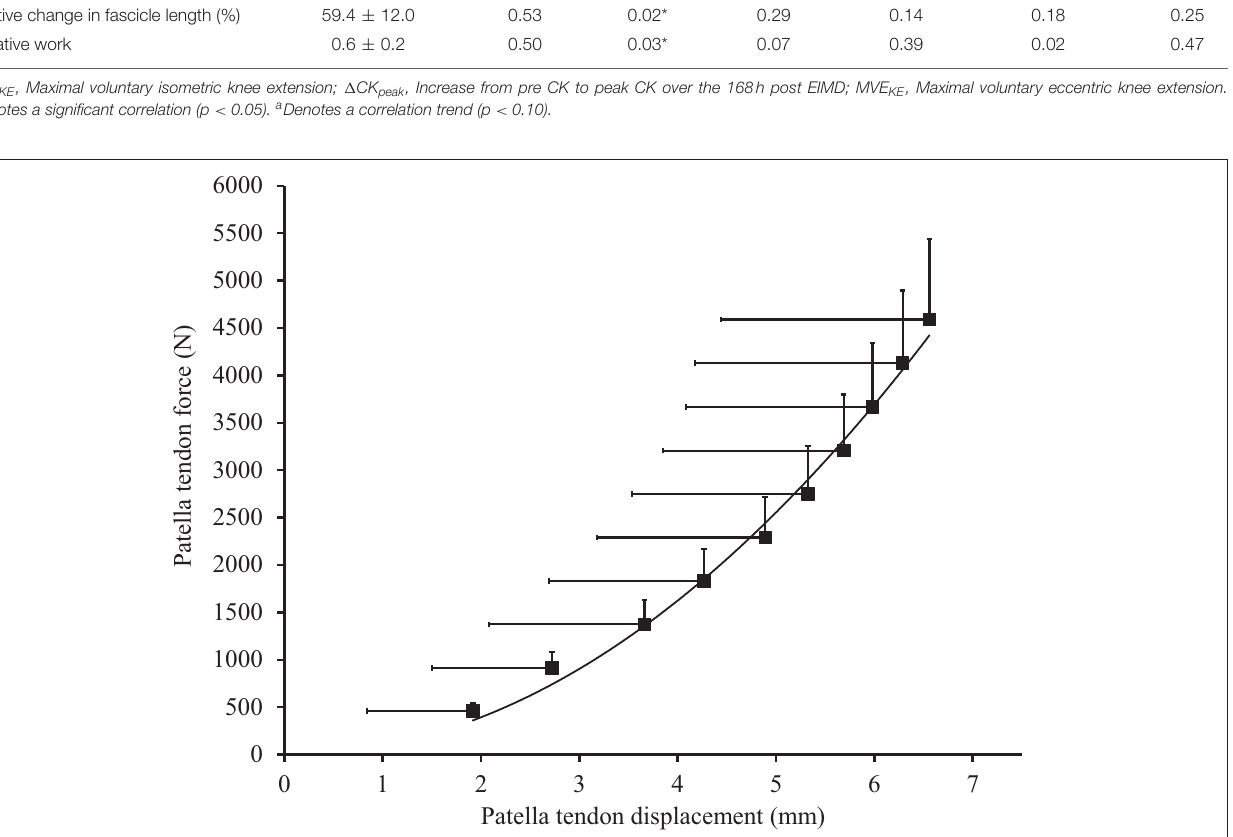
Patella tendon displacement (mm) FIGURE 1 | Patella tendon force-displacement relationship in males. Values are presented as mean ± standard